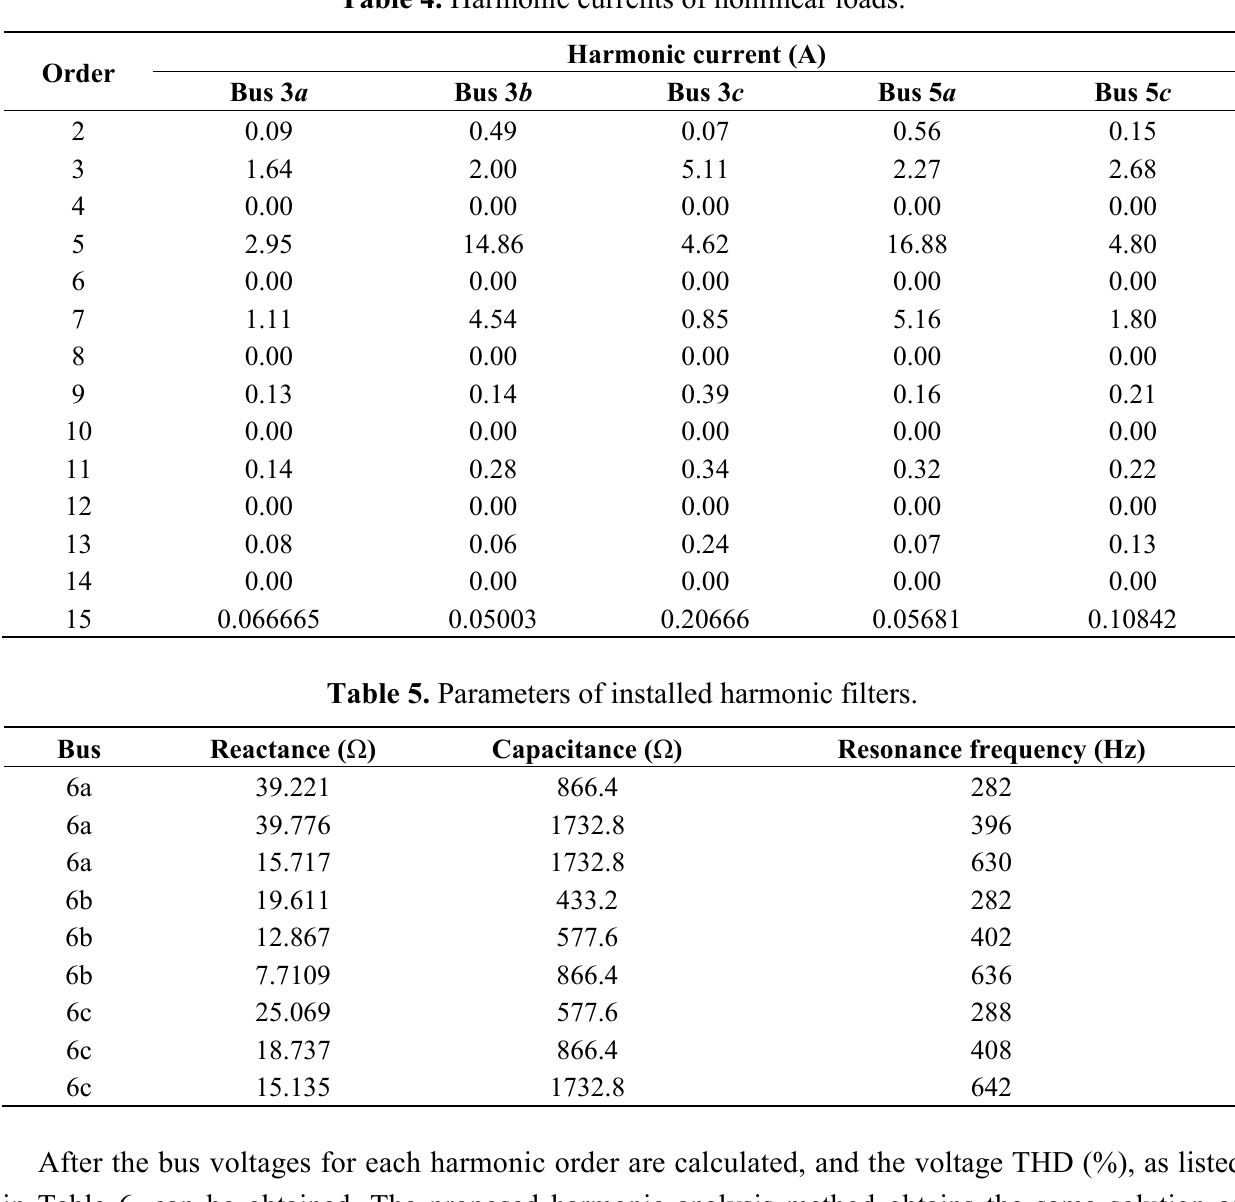
Table 4. Harmonic currents of nonlinear loads.